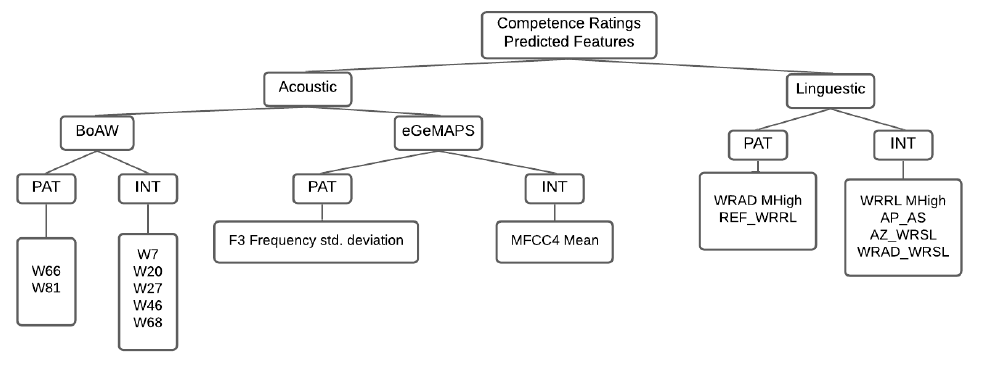
Figure 4. The best acoustic and linguistic features for predicting the total competency measure (std. deviation = standard deviation, PAT = patient, INT = practitioner).